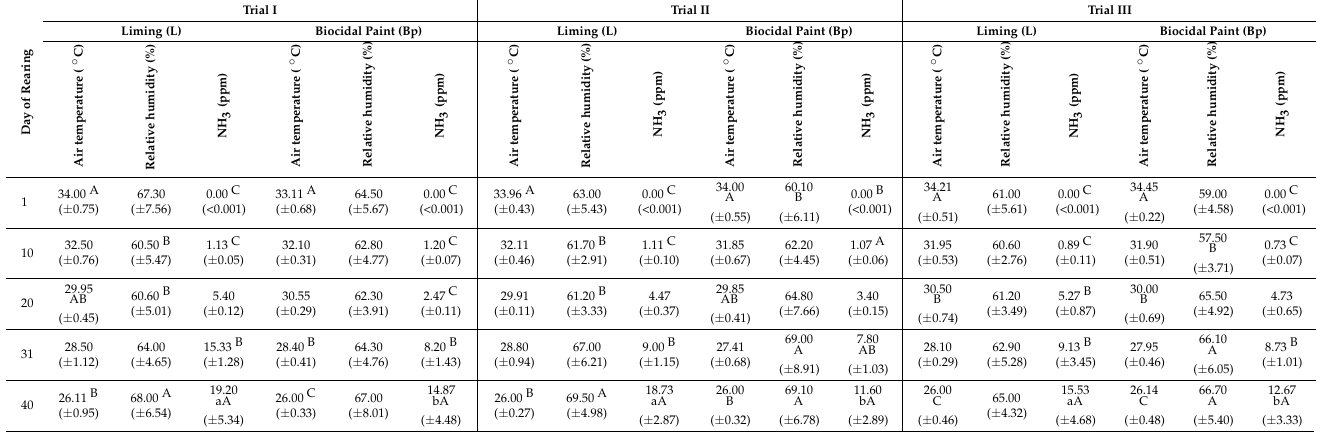
Table 9. Air microclimate parameters during the